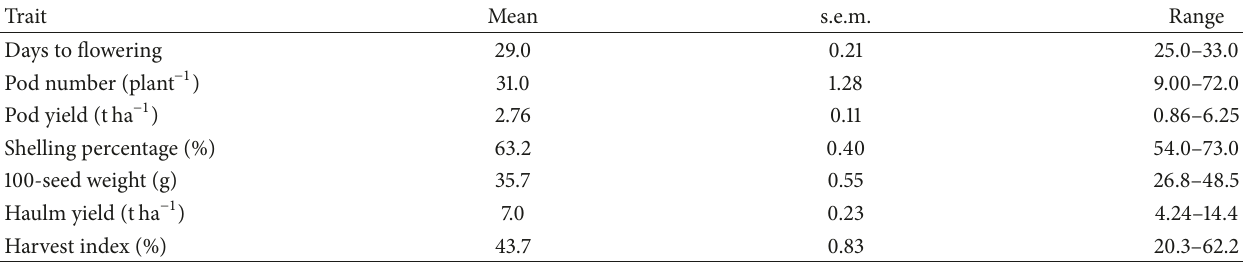
Table 2: Summary statistics of 30 groundnut genotypes grown at Nyankpala in 2015.